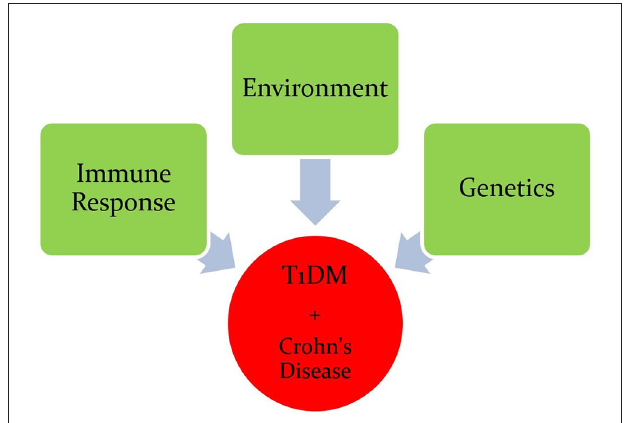
FIGURE 1 | Interplay between genetic predisposition, environmental factors, and the immune system in Crohn’s disease and T1D.